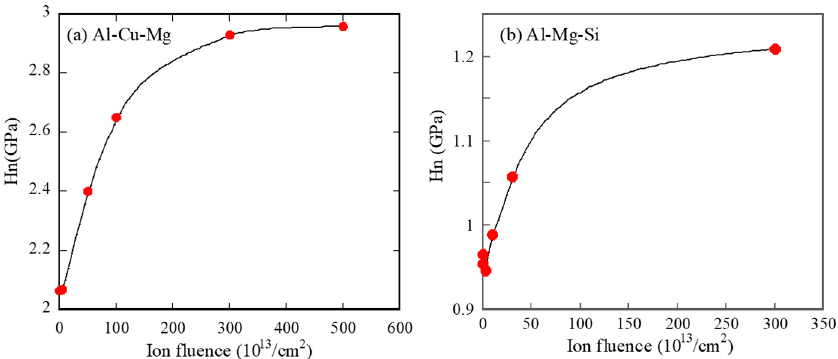
Figure 9. Nanoindentation hardness as a function of 10 MeV I ion fluence for ( a ) Al-Cu-Mg alloy and ( b ) Al-Mg-Si alloy.